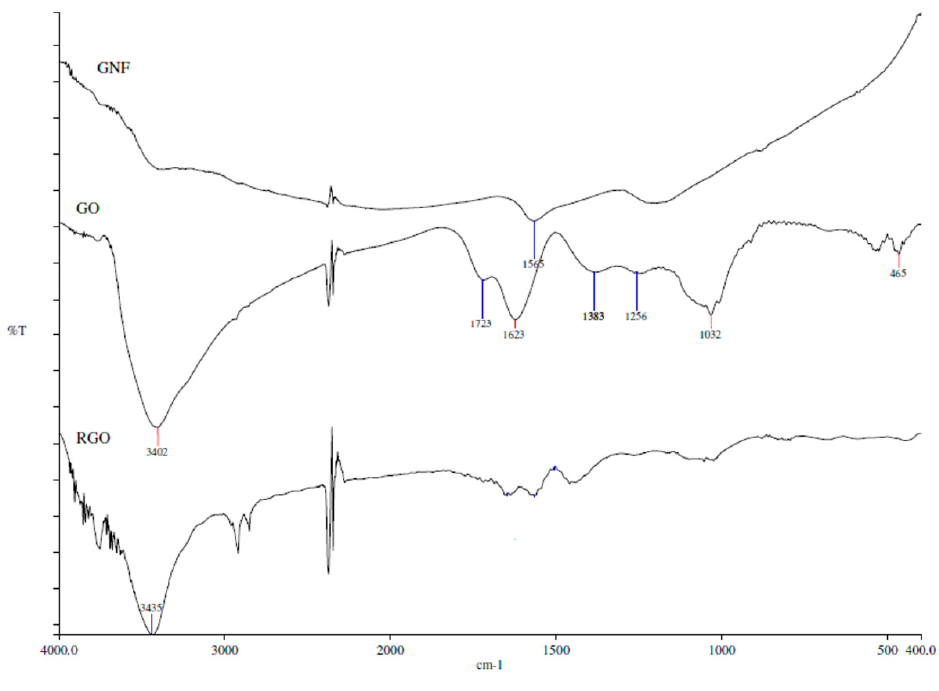
Figure 5. FTIR spectra of GNF, GO and RGO.